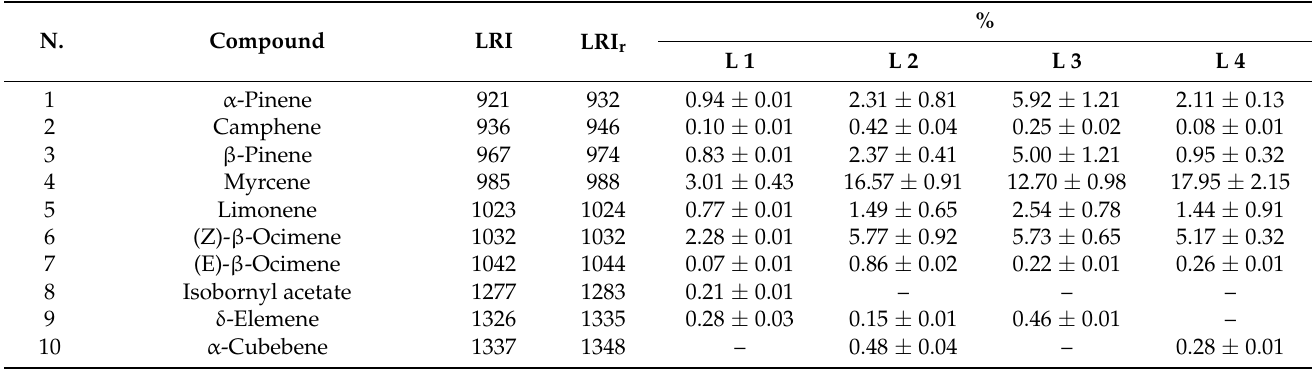
Table 1. Chemical composition of the essential oil of S. muricata in